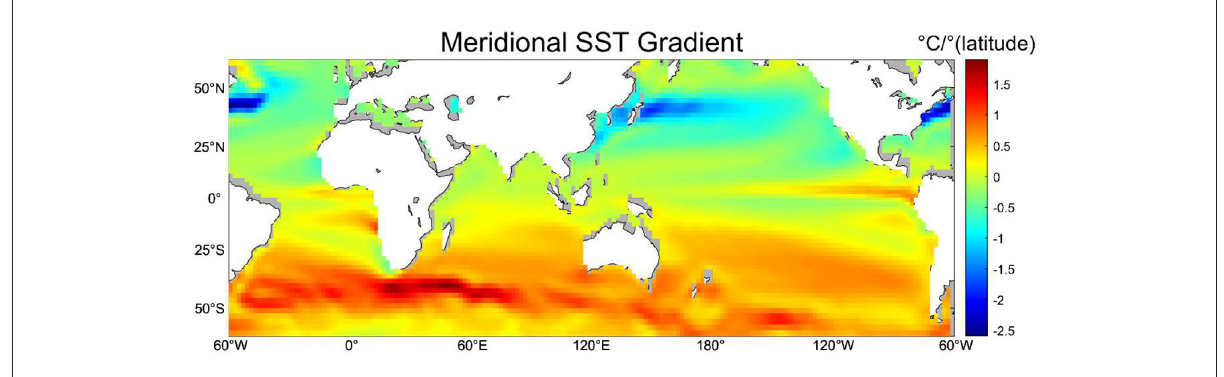
FIGURE2 Global distribution of the meridional SST gradient.